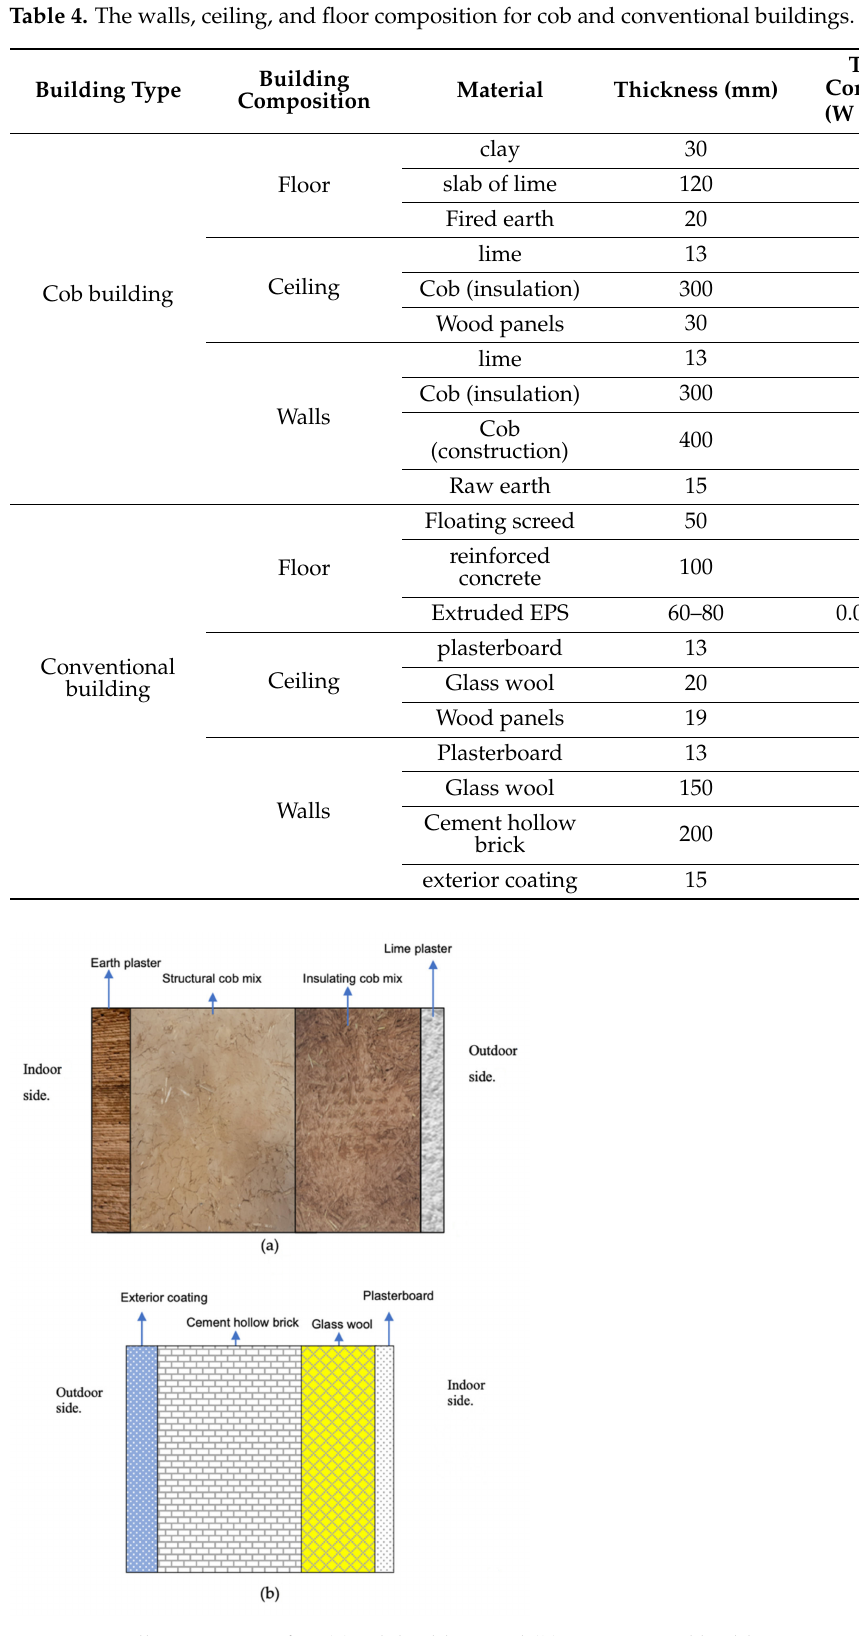
Figure 8. Wall composition for: ( a ) cob building and ( b ) conventional